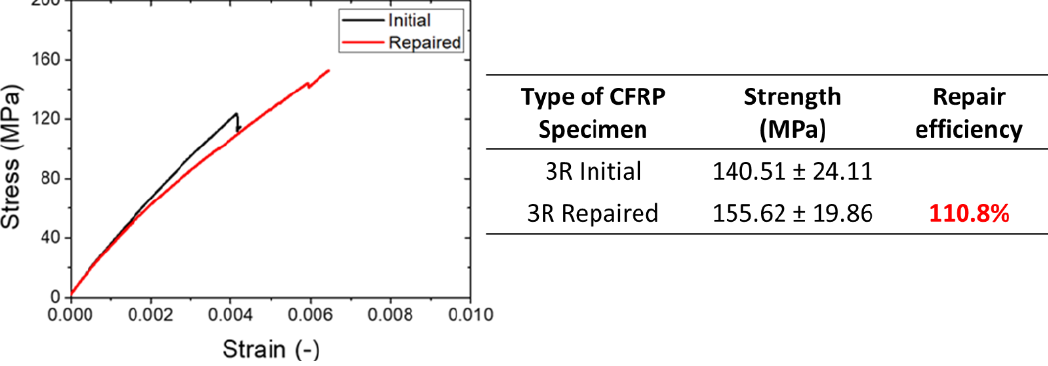
Figure 29. Representative stress – strain plots ( left ) and repair efficiency values ( right ) of lap strap specimens.